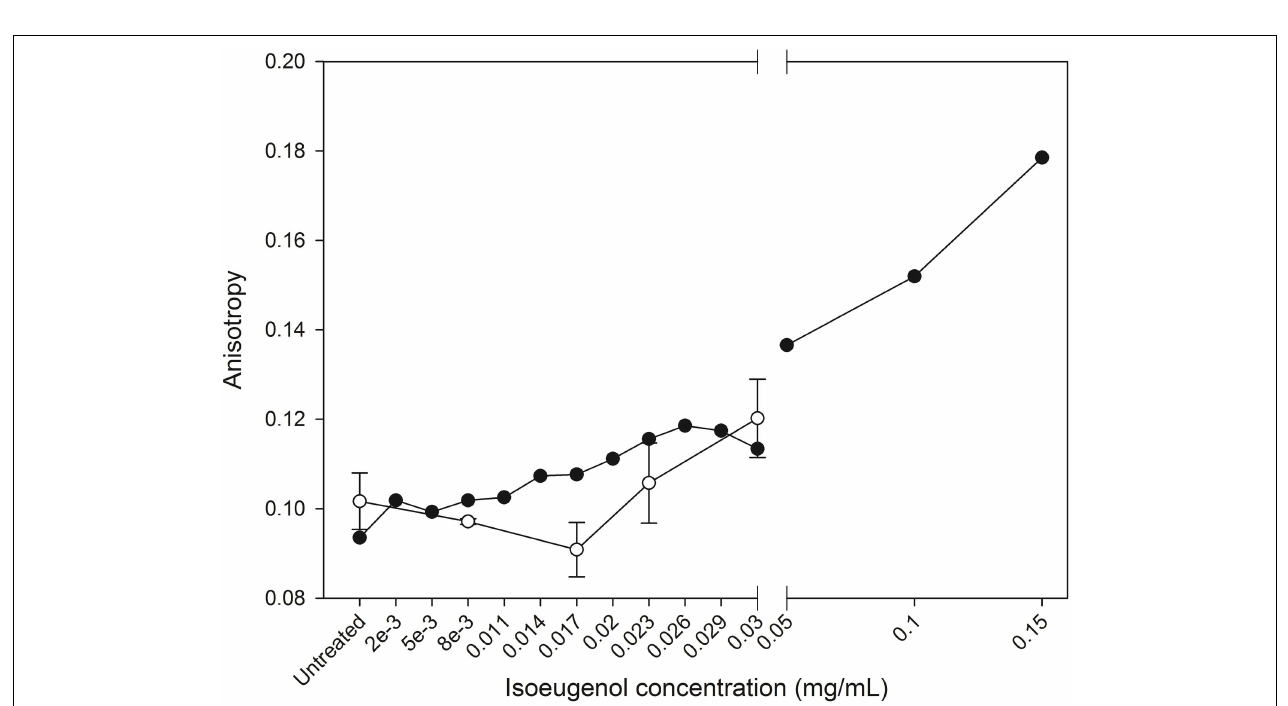
FIGURE 8 | Isoeugenol’s effect on large unilamellar vesicles fluidity. Fluorescence anisotropy of diphenylhexatriene in vesicles composed of DOPG:DOPC (20:80) (black circles) or E. coli polar lipid extract (white circles) were measured as a function of increasing concentrations of isoeugenol in MES-buffer (pH 6.0) at 25 or 37 ◦ C, respectively. Anisotropy is a measure of